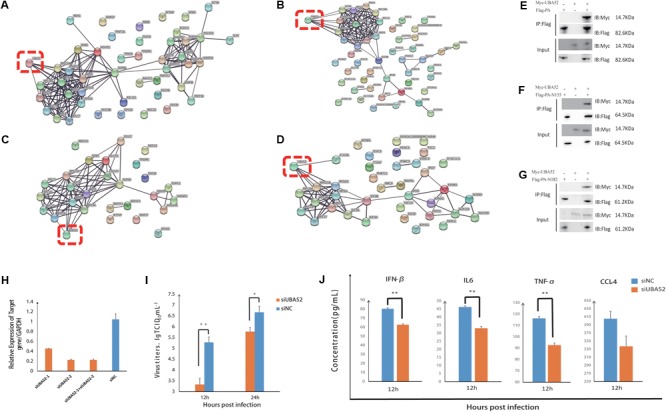
UBA52 influences IAV replication in DF1 cells. (A) Interaction network of the identified proteins with PA-N155 that are involved in RNA processing. (B) Interaction network of the identified proteins with PA-N155 that are involved in viral processes. (C) Interaction network of the identified proteins with PA-N182 involved in RNA processing. (D) Interaction network of the identified proteins with PA-N182 involved in viral processes. Red points represent UBA52 and the other colors represent the other identified proteins involved in RNA processing or viral processes. (E–G) Co-IP assay confirming the interaction between UBA52 and PA, PA-N155 or PA-N182. (H) Knockdown efficiency of UBA52. DF1 cells were transfected with siNC or siUBA52. The result shown is from quantitative PCR performed 24 h after infection. (I) Progeny virus titers decreased significantly after transfection of DF1 cells with siUBA52 at 12 and 24 hpi. The results are presented as the mean ± SD from three independent experiments. ∗p < 0.05 compared with cells transfected with siNC. ∗∗p < 0.01 compared with cells transfected with siNC. (J) Cytokines and chemokines expression in the DF1 cells. Cytokine or chemokine expression was expressed as the mean ± SD concentration. ∗p < 0.05 compared with cells transfected with siNC. ∗∗p < 0.01 compared with cells transfected with siNC.